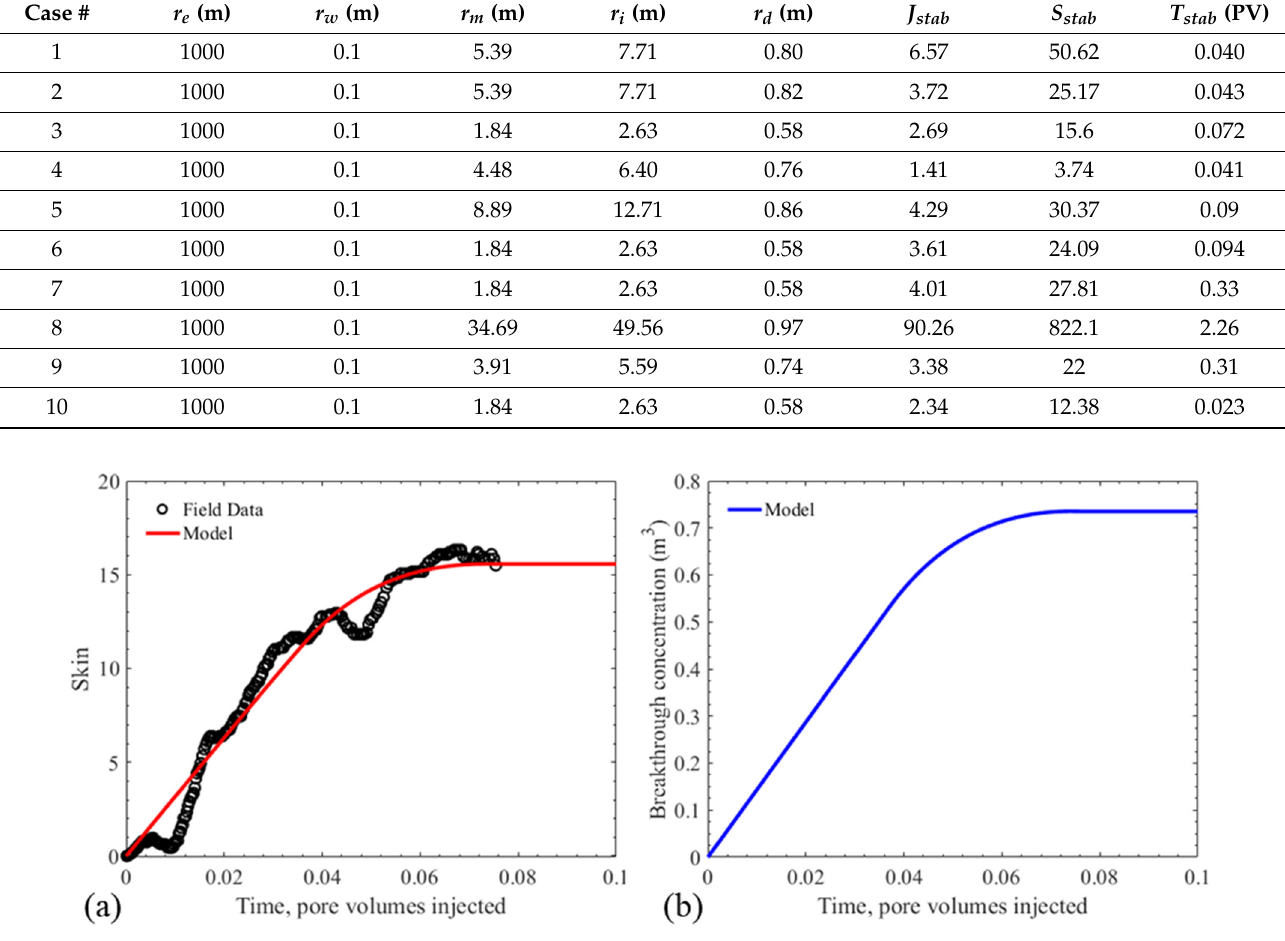
Figure 11. Results of tuning three model coefficients (filtration and formation damage coefficients, and drift delay factor) for a well during the later stages of skin growth (Case 3 from Kamps, Chando and Ellis [4]), ( a ) skin vs. PVI, ( b ) the cumulative fines production at the wellbore vs. PVI.